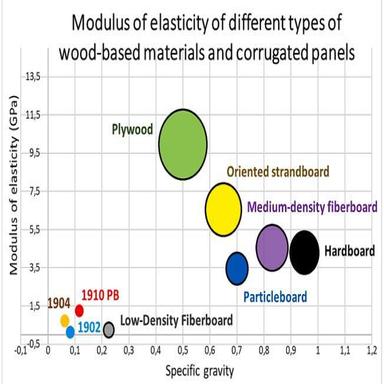
Modulus of elasticity of different types of wood-based materials and corrugated panels .